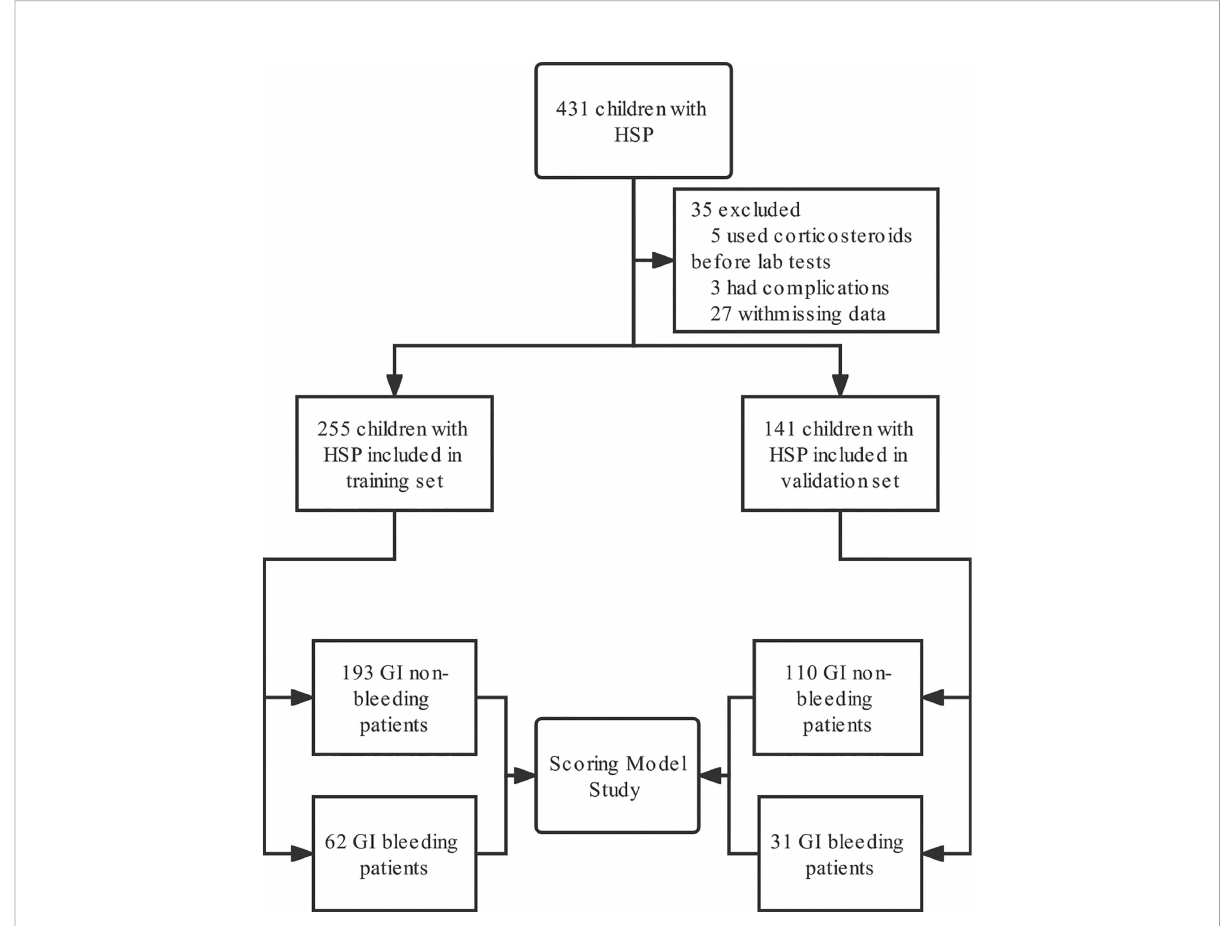
FIGURE 1 Flow chart of study subject inclusion. GI, gastrointestinal; HSP, Henoch-Schönlein